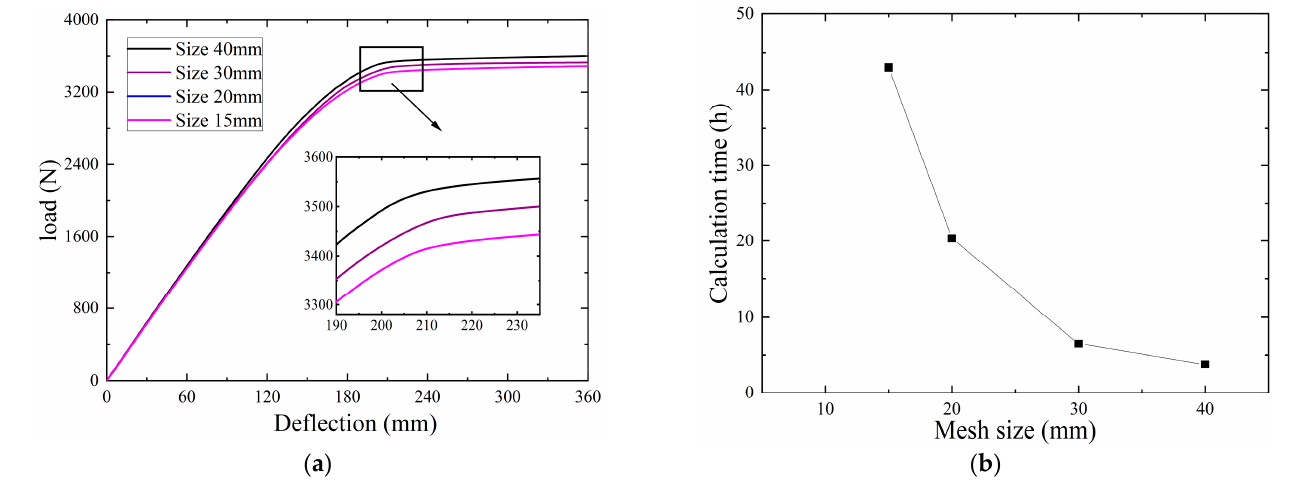
Figure 13. The effect of mesh size on the accuracy and efficiency: ( a ) Load–deflection curves with different mesh sizes ( b ) Calculation vs mesh size.